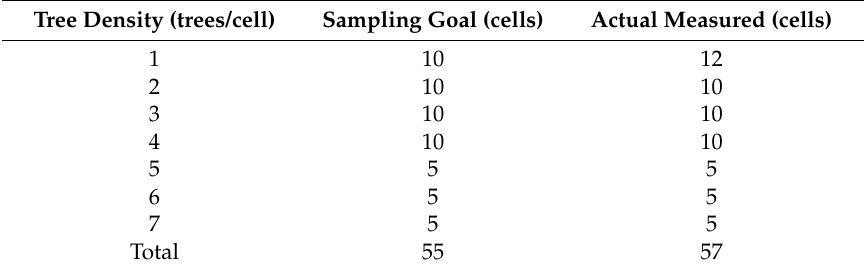
Table 1. Distribution of the field samples. Field sampling was stratified by tree density to collect individual tree measurements in areas of varying density. The sampling goal was to measure 10 cells with a density of 1, 2, 3, and 4 trees/cell, and 5 cells with a density of 5, 6, and 7 trees/cell. The sampling goal was met at all densities. Tree Density (trees/cell) Sampling Goal